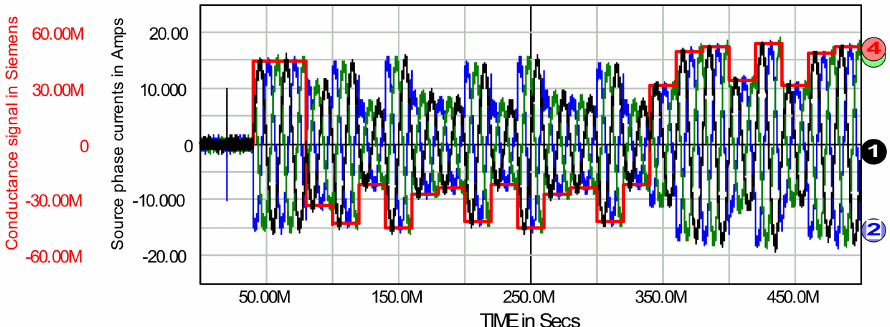
Figure 14. Source phase currents of phase A, B, and C as waveforms 1, 2, and 3, respectively, and the conductance signal, waveform